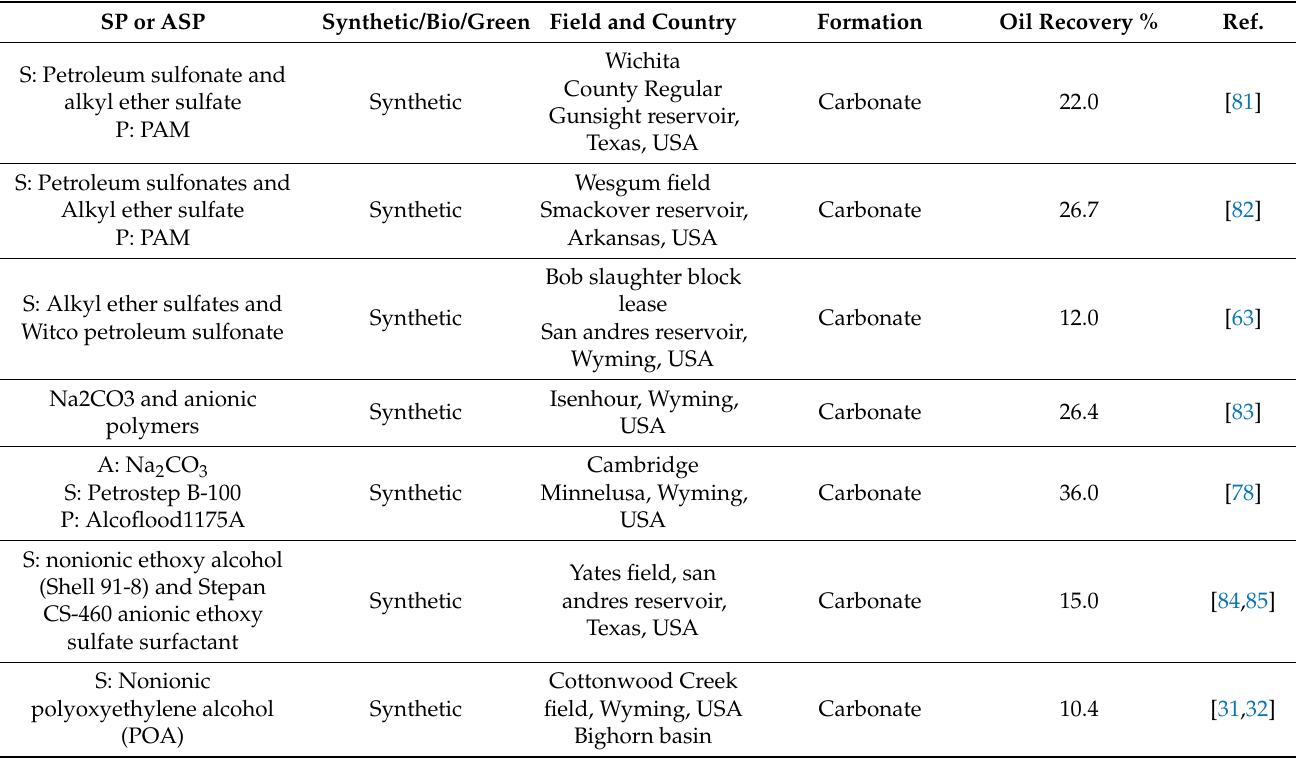
Table A3. Application of the SP or ASP formulation in carbonate